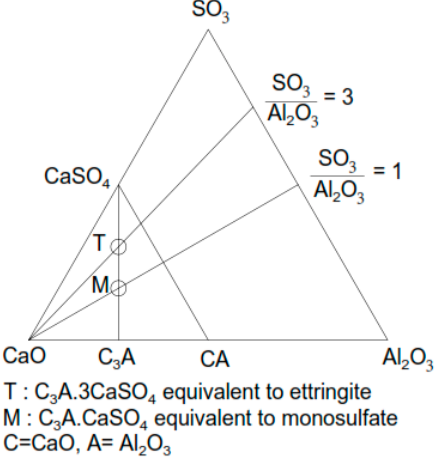
Figure 1. Expansive compounds present in cement [48].